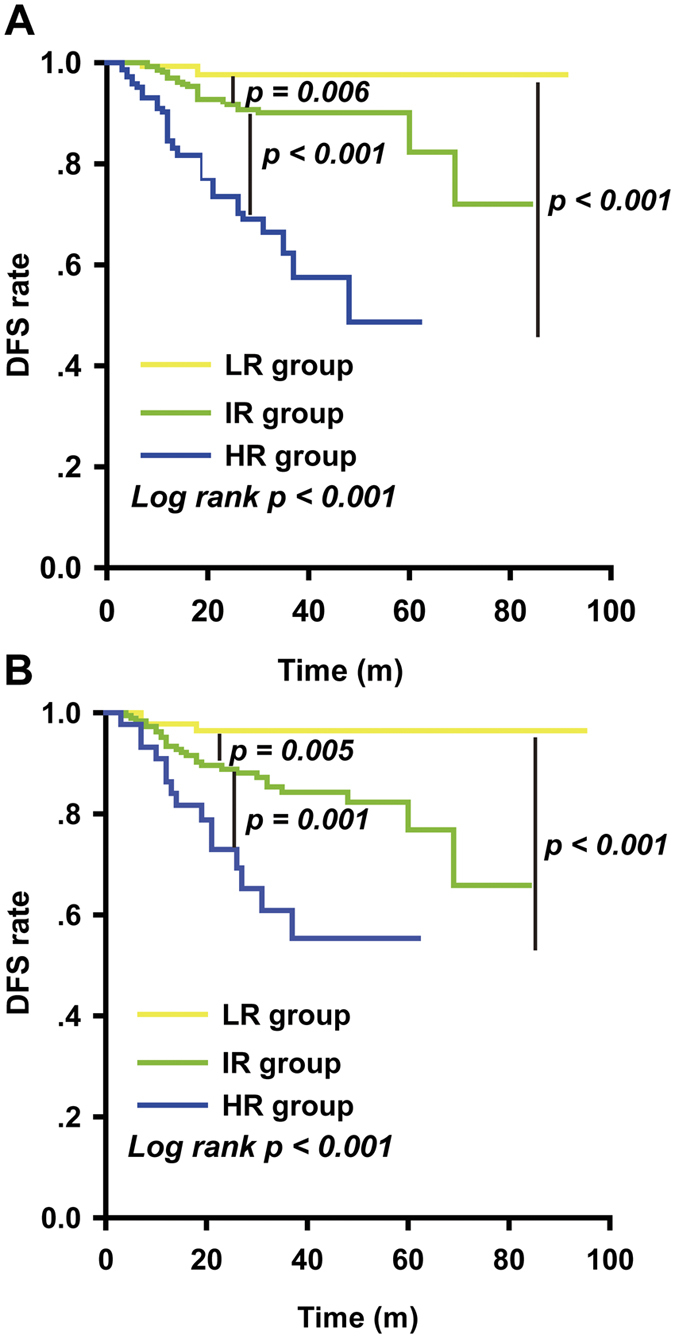
Kaplan-Meier survival estimates of evaluated patients with cervical cancer from both the (A) training study and the (B) validation cohort. Kaplan-Meier survival estimates for low-, intermediate- and high-risk patients with cervical cancer, as defined by the risk model. Disease-specific survival curves of evaluated patients in the (A) training study and (B) validation cohort. Log-rank test was used to calculate p values. Statistical significance was observed between the groups.